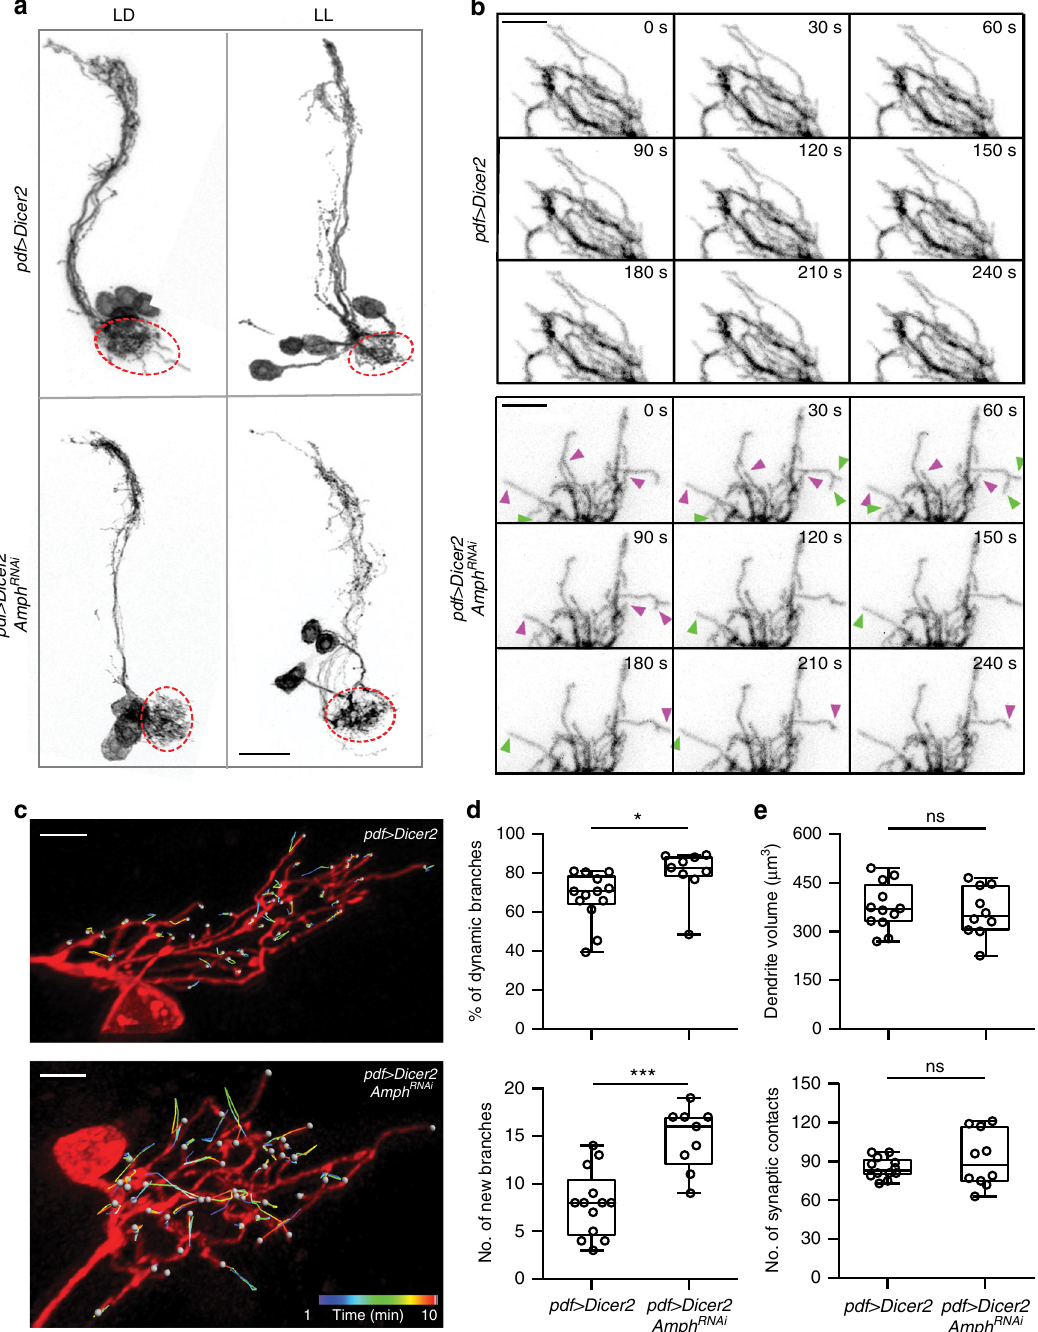
Fig. 6 RNAi knockdown of Amph elevates dendritic dynamics in LNv without affecting dendrite morphology. a Knocking-down Amph expression does not affect LNv dendrite morphology in both LD and LL conditions. Representative projected confocal images of LNvs collected at 120 h AEL are shown. Genotypes and culture conditions were as indicated. Dendritic fi eld are circled with dashed lines (red). b Knocking-down Amph led to increased number of dynamic events at 120 h in LL. Representative cropped frames from live imaging series are shown. Extensions (green) and retractions (magenta) were only observed in the LNv expressing RNAi targeting Amph. Scale bar, 5 μ m. c Knocking-down Amph in LNvs increases dendrite dynamics without affecting dendrite morphology. Representative tracking trajectories generated by movements of dynamic fi lopodia in single-labeled LNvs are shown. Genotypes are as indicated. d Compared to the control, both the percentage of dynamic branches and the number of newly appeared branches increase signi fi cantly in the Amph knockdown group. n = 13, pdf > Dicer2 ; n = 9, pdf > Dicer2, Amph RNAi . Statistical signi fi cance was assessed by two-tailed Student ’ s t -test. Dynamic branches (Top): t 20 = 2.243, P = 0.036. New branches (Bottom): t 20 = 4.657, P < 0.001. e Knocking-down Amph does not affect LNv dendrite volume or the number of Brp puncta contacting LNv dendrites (synaptic contacts). n = 12, pdf > Dicer2 ; n = 10, pdf > Dicer2, Amph RNAi . Statistical signi fi cance was assessed by two-tailed Student ’ s t -test. Volume (Top): t 20 = 0.503, P = 0.62. Synaptic contacts (Bottom): t 20 = 1.015, P = 0.322. Data are presented as box plot (box, 25 – 75%; center line, median) overlaid with dot plot (individual data points). ns, not signi fi cant; *P < 0.05, **P < 0.01, ***P <